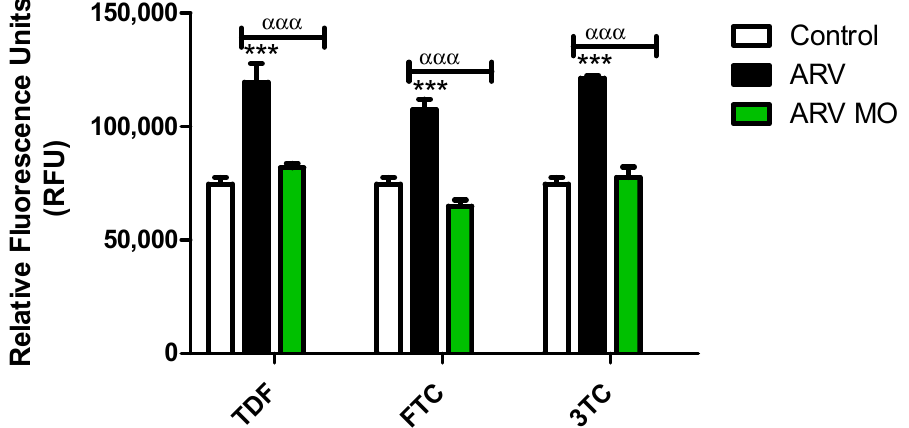
Figure 1. Assessment of ROS generation post-ARV and post-ARV MO treatment. TDF, FTC, and 3TC significantly increased the levels of ROS, while ARV MO displayed a significant reduction in ROS in HepG2 cells. * Represents a significant difference between the control and ARV (***, p < 0.0001). α Represents a significant difference between ARV and ARV MO ( ααα , p < 0.0001).